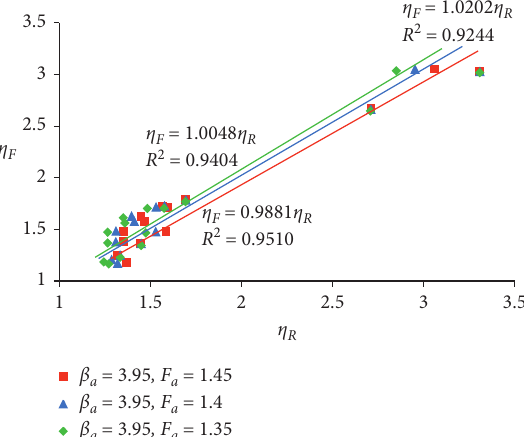
Figure 10: The correlation of η slopes).